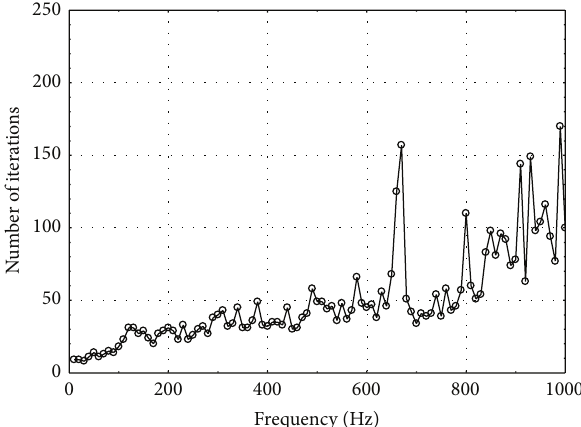
Figure 9: Total number of iterations considering different frequen- cies and 55 collocation points for the MFS and 66 boundary points for the KM, at each circular